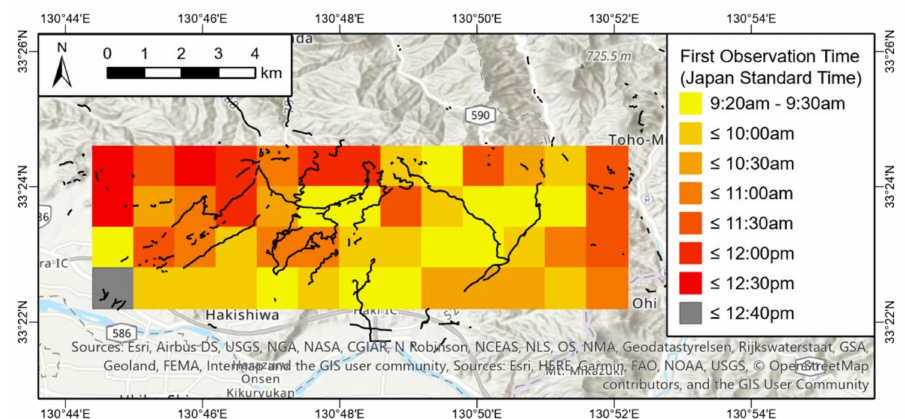
Figure 12. AHI first clear-sky observation time on 13 July 2017. The first sunny conditions after the torrential rain event of 5 July 2017 occurred over this region on that date. The damaged roads [24] are shown as black lines for reference. The map was created with ArcGIS ® software (ArcGIS ® Pro 2.4.1, Esri, Redlands, CA, USA, http: //